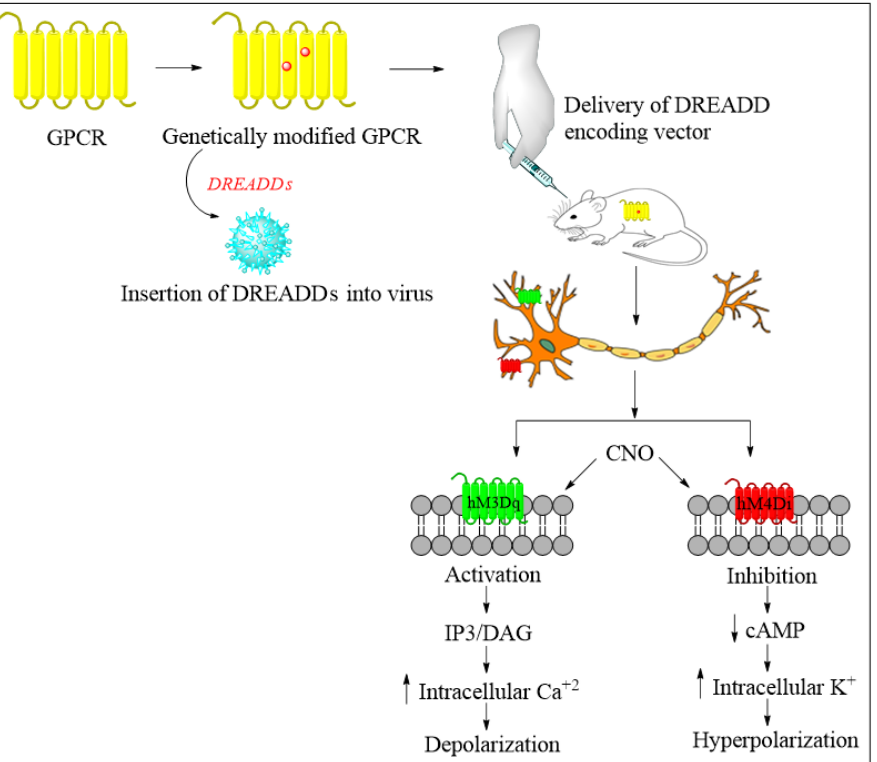
Figure 6. Chemogenetic approach for the silencing of a neural circuit in the brain and spinal cord to treat neuropathic pain. Genetically modified GPCR (DREADD) is developed by a novel directed molecular evolution approach using a biologically inactive metabolite of clozapine, CNO, as the synthetic ligand, and the human M3 receptor (M3R) for initial mutagenesis. This DREADD is inserted into the virus vector. Then, the DREADD encoding vector is inserted into the rat for its expression. CNO binding to hm3Dq and hm4Di leads to neuronal firing and silencing, respectively. Neural silencing of nociceptive signals in the brain and spinal cord by the hyperpolarization of neurons is the approach to treating neuropathic pain. G-protein-coupled receptor, GPCR; designer receptor exclusively activated by designer drugs, DREADDs; clozapine-N-oxide, CNO; human muscarinic receptor 3, hm3Dq; human muscarinic receptor 4, hm4Di; inositol triphosphate, IP3; diacylglycerol, DAG; cyclic adenosine monophosphate, cAMP.